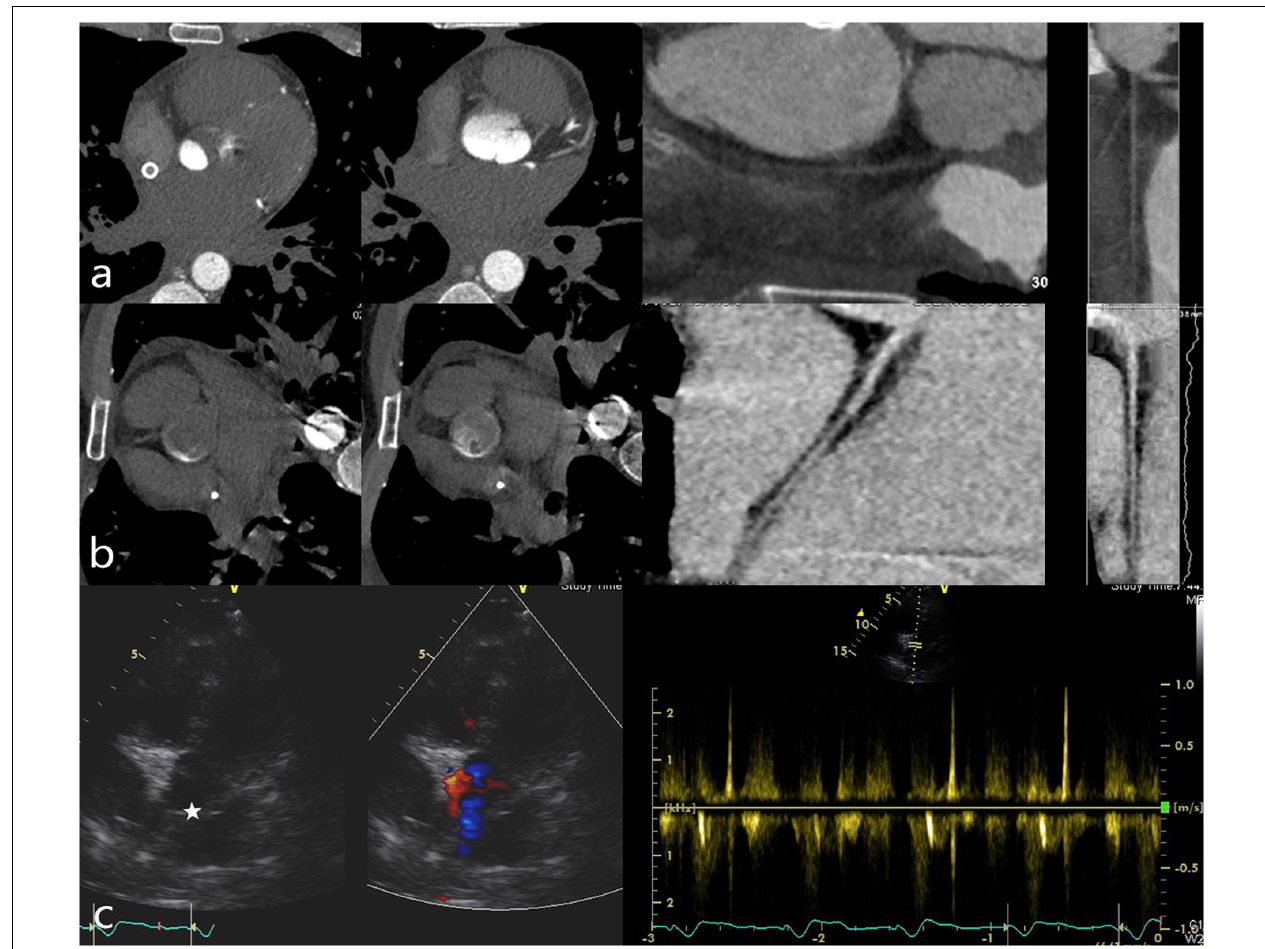
FIGURE 3 | (a) Patient in the supine position. The axial view demonstrated an arc-shaped low-attenuation filling defect (“watershed” phenomenon) in the root of the aorta while the DAO was filling well. The multiplanar reformatted image from the CTA showed no contrast agent filling in the right coronary. (b) Patient in the right lateral decubitus position. The arc-shaped low-attenuation filling defect disappeared and the right coronary filled well. (Left dominant coronary artery; (c) The echocardiography (GE Vivid E95; 45 ◦ reclining position; Five-chamber view) demonstrated the extremely low velocity of the aortic valve and there was no thrombus formation in the aortic root (white